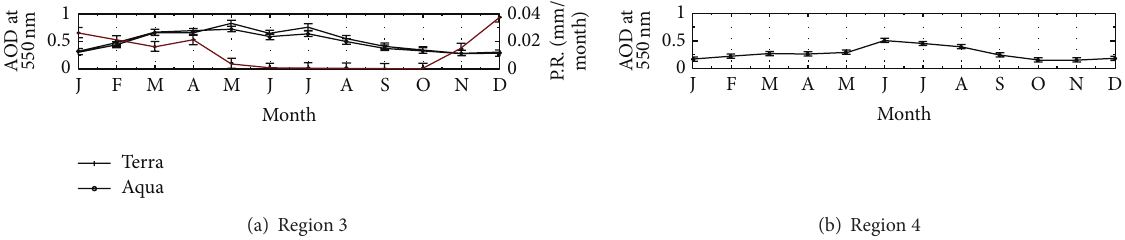
Figure 3: Climatology MODIS monthly AOD means over (a) region 3 (EP) from Terra and Aqua (2003–2013), the right axis is for the precipitation rate of the EP for the same period, (b) region 4 (Rub al Khali) with standard deviations. 5 4 3